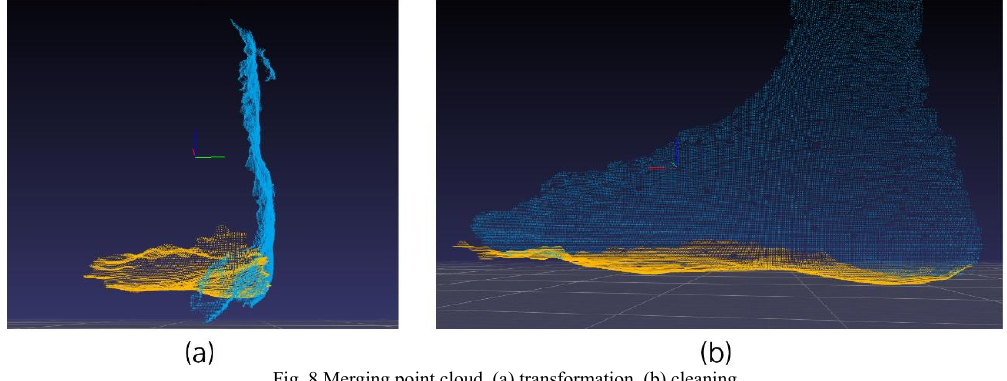
Fig. 8 Merging point cloud, (a) transformation, (b) cleaning